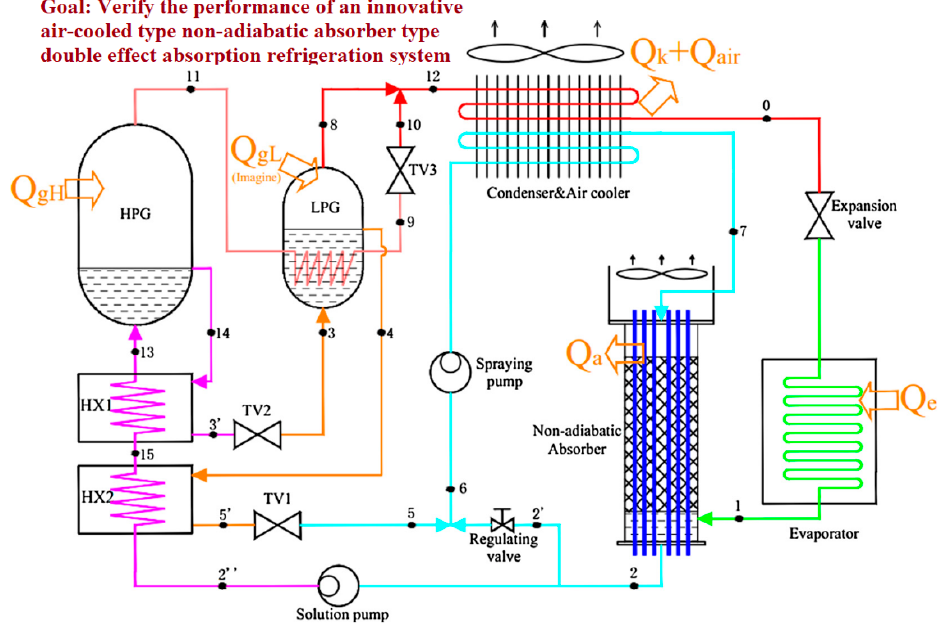
Figure 6. Absorption/compression refrigeration hybrid cycle. Adapted from Cai et al. [65] (Reprinted with permission from Elsevier) .